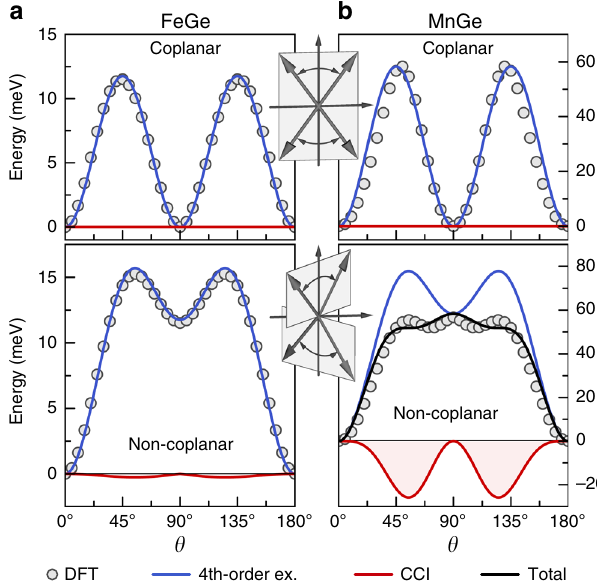
Fig. 3 Beyond-Heisenberg interactions in B20 germanides. Angular dependence of the total energy without spin-orbit coupling for coplanar ( ϕ ¼ 0 (cid:4) ) and non-coplanar ( ϕ ¼ 45 (cid:4) ) antiferromagnetic spin con fi gurations in a FeGe and b MnGe. Circles denote the fi rst-principles results whereas blue and red solid lines indicate the fi tted 4th-order exchange and chiral-chiral (CCI) contributions, respectively. Note the difference of scales between a and b .